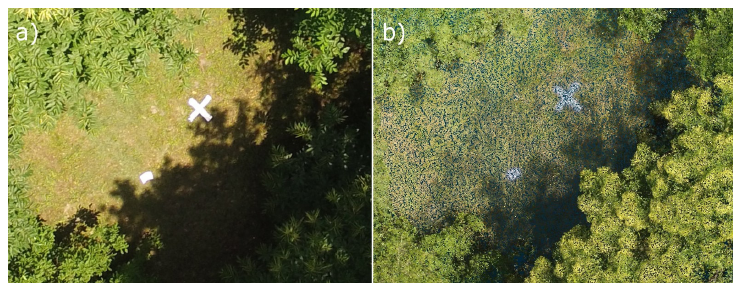
Figure 2. Ground control point and checkpoint: ( a ) photo; and ( b ) point cloud.